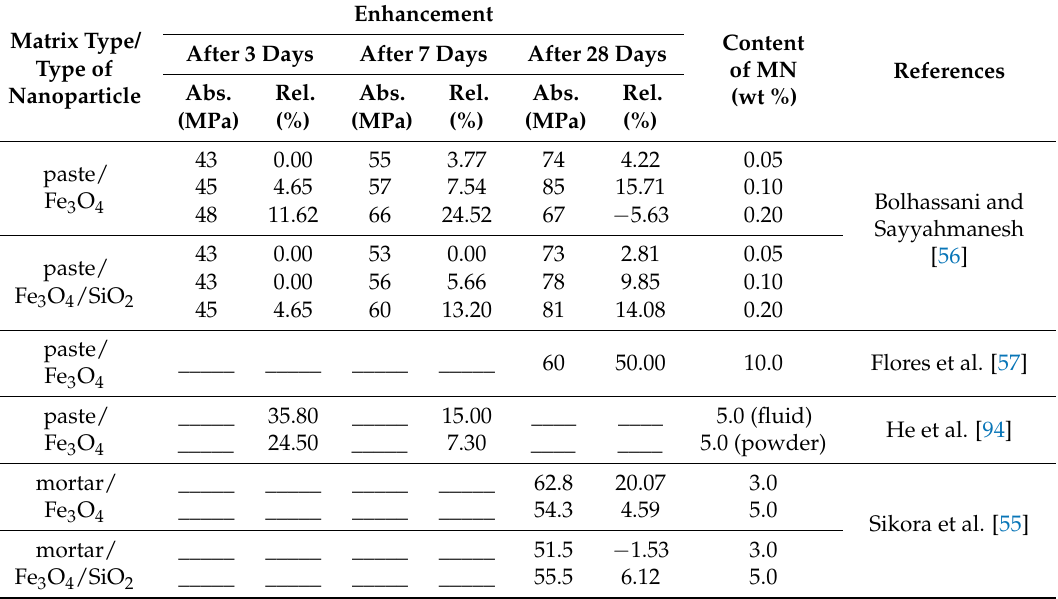
Table 3. The effect of MN on the compressive strength of cement